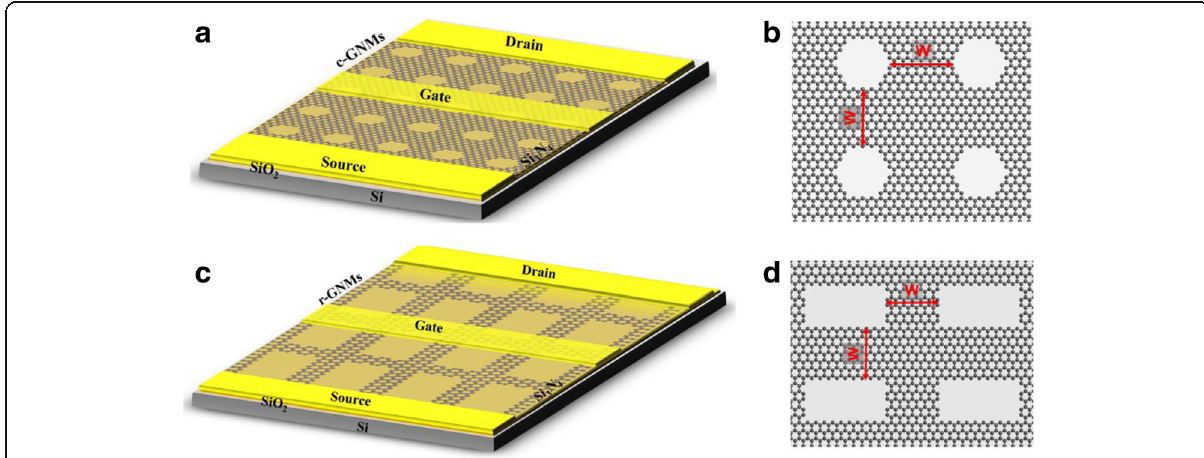
Fig. 2 a Schematic illustration of the fabricated terahertz detectors based on c-GNM. b The structural schematic of c-GNM, where W is the neck width. c Schematic illustration of the fabricated terahertz detectors based on r-GNM. d The structural schematic of